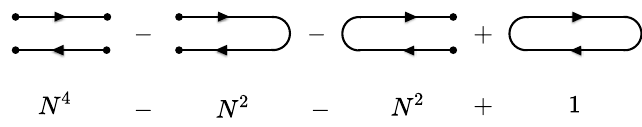
Figure 13 . The left (cid:12)gure illustrates the diagrammatic computation for the number of open string edge modes for n = (cid:22) n = 1. As expected, this gives the square of the dimension of the adjoint representation, ( N 2 1) 2 (cid:0)